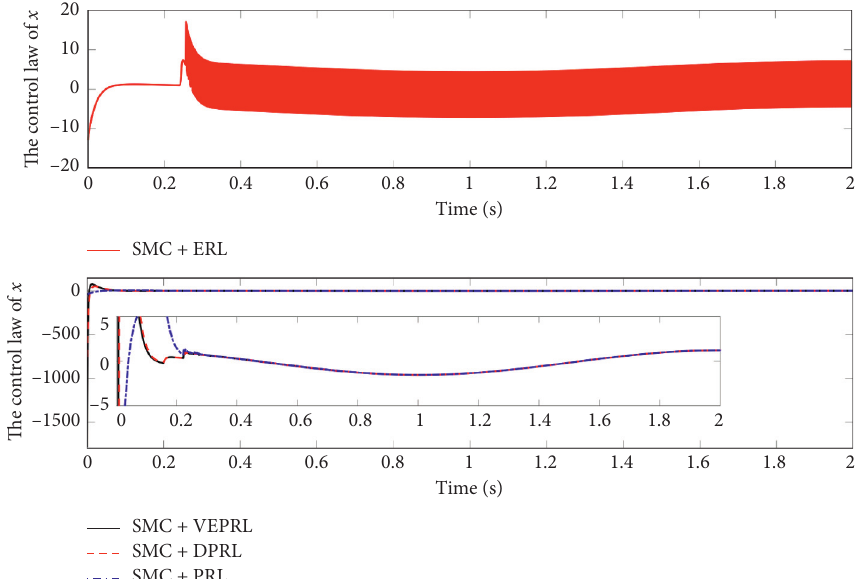
Figure 7: The control law of ( x ) under